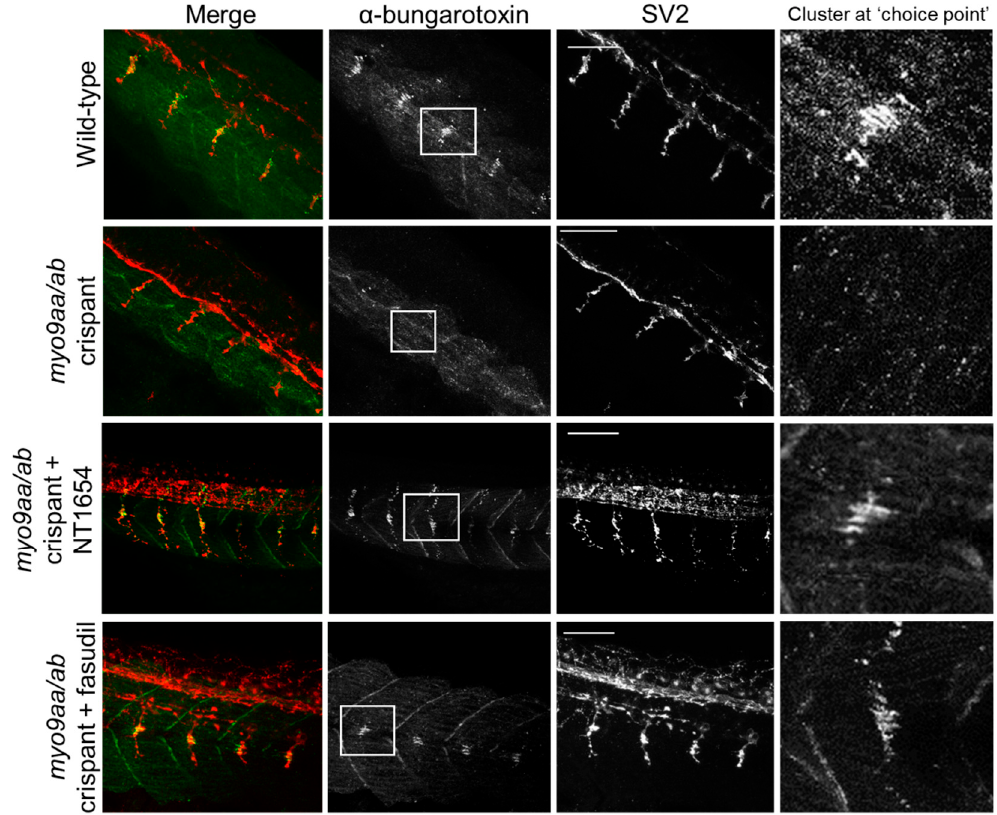
Figure 3. Neuromuscular junction (NMJ) morphology of myo9aa/ab crispant zebrafish at 24 hpf. Representative images of NMJs in wildtype, myo9aa/ab crispant, and NT1654 (0.15 ng) or fasudil-treated (10 µm) crispant zebrafish at 24 hpf. Acetylcholine receptors stained with α BTx (green), and motor neurons detected with an antibody against SV2 (red). White boxes demark areas enlarged in the right-hand panel, showing presence of α BTx-positive choice point clusters. Scale bar = 50 µm.